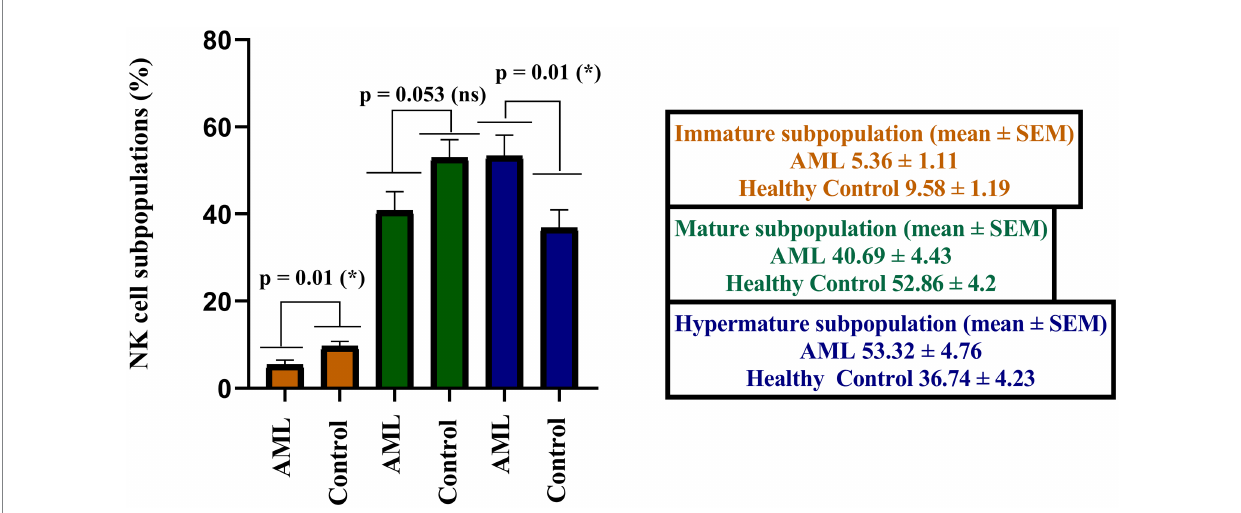
FIGURE 3 Comparison of cell percentages in distinct NK maturation subpopulations of AML ( n = 19) and healthy control ( n = 20) – immature (orange), mature (green) and hypermature (blue). Bars represent the mean ± SEM (p < 0.05 (*); ns, not significant; two tailed unpaired t -tests).